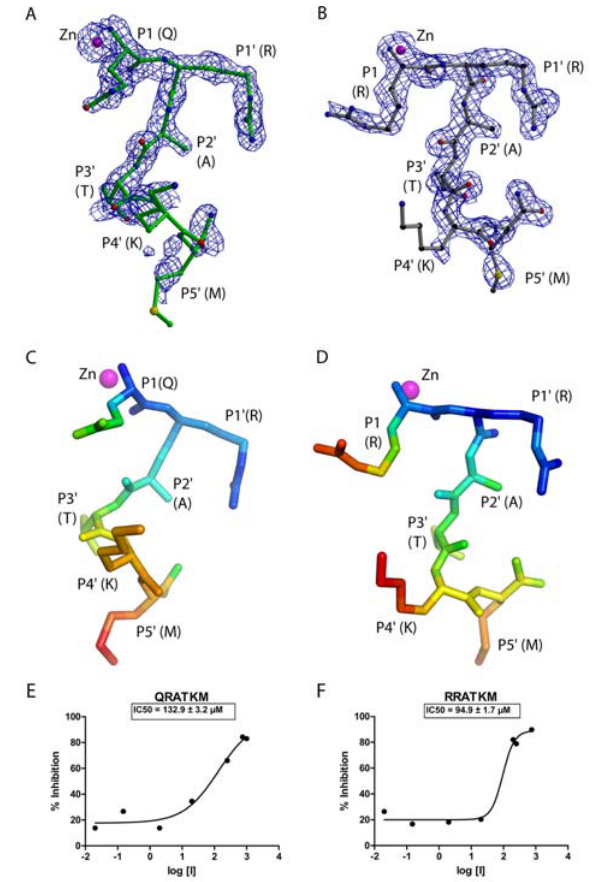
Figure 1. Hexapeptides and inhibition plots. Electron density maps (blue mesh) for bound substrate (QRATKM) and its variant (RRATKM) are shown in A and B, respectively. The electron density is from composite omit maps (2|F o |-|F c |) and contoured at 1 s level. QRATKM (green) and RRATKM (gray) peptides are shown in ball and stick model. Zinc, oxygen and nitrogen atoms are shown as magenta, red and blue spheres, respectively. Carbon atoms are shown in green (QRATKM) and black (RRATKM). Figures were prepared using Molscript, Raster3D and Bobscript [34–36]. Distribution of B factors for the QRATKM and RRATKM are shown in C and D, respectively. The peptide atoms are colored according to B factor with RGB (Red-Green-Blue) color ramp with blue and red corresponding to the lowest (17 A˚ 2 ) and highest (50 A˚ 2 ). Pymol (DeLano, W.L. The PyMOL Molecular Graphics System (2002) on World Wide Web http://www.pymol.org) was used